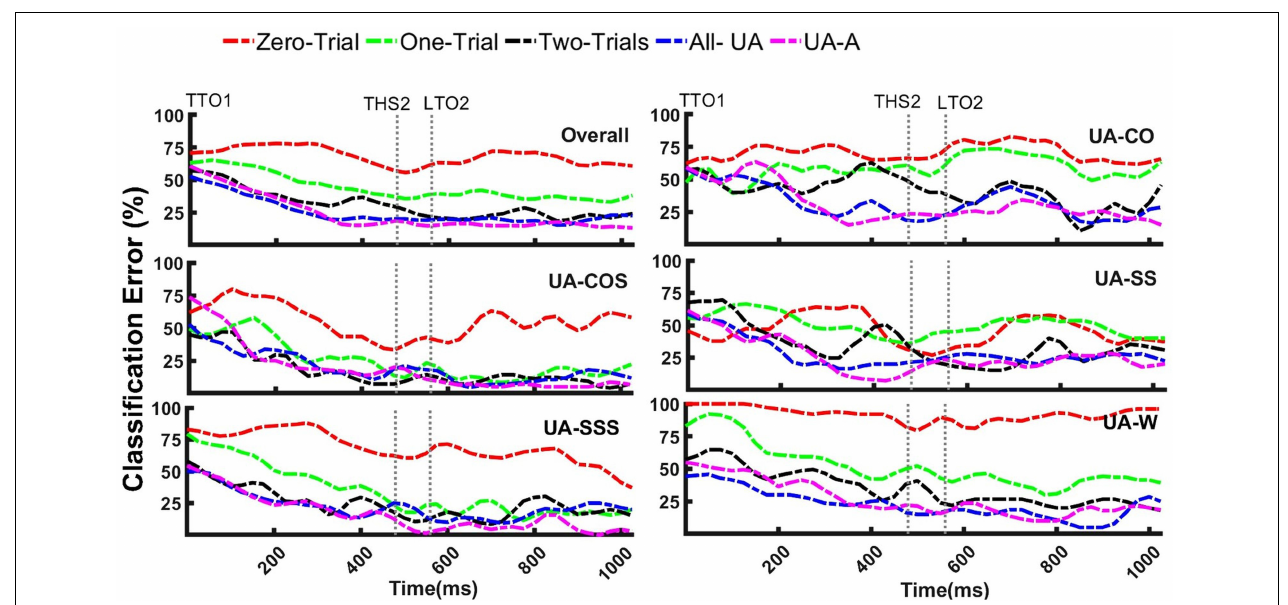
FIGURE 6 | The influence of training paradigms with varying exposures of target task on recognition of unanticipated straight walking (UA-W), cuts (UA-CO, UA-SS), and cuts to stair ascent (UA-COS, UA-SSS) over time. Even though including a few bouts of target locomotion significantly decreased error rates in mixed transitions (UA-COS, UA-SSS), maximum exposures of unanticipated information were required to provide robust recognition in single transitions (UA-CO, UA-SS) and UA-W. To execute cut, subjects started the transition at the first trailing leg toe off (TTO1) and ended with the second trailing leg heel strike (THS2). LTO2 stands for the second leading leg toe off. Events are the average across subjects. X -axis data was shown up to the length of the shortest trial.